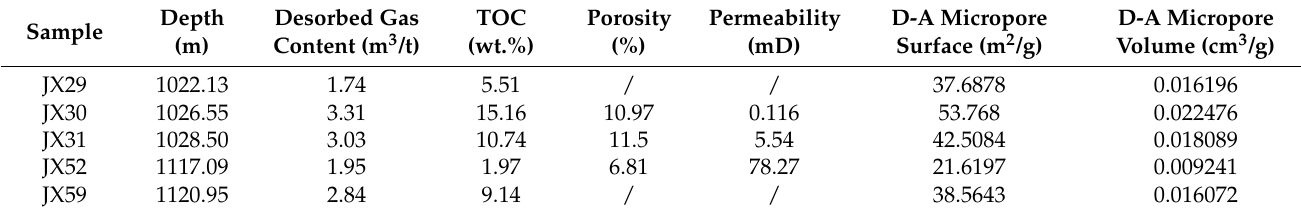
Table 2. TOC content, porosity, permeability, micropore characteristics, and desorbed gas content of shale core samples in well ZY-1./means not be